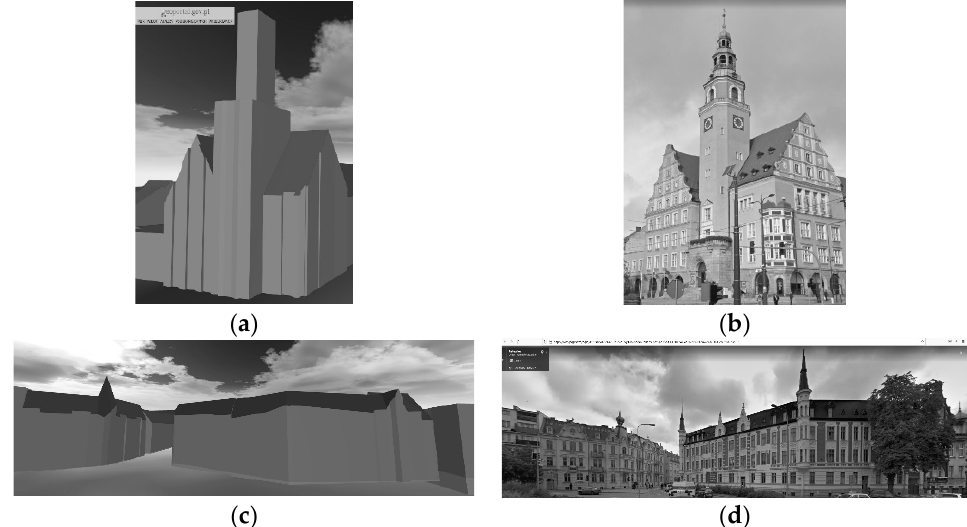
Figure 1. Selected 3D building models from the Polish SDI Geoportal, including Street View visualizations; ( a ) Model of the Olsztyn City Hall building; ( b ) Visualization of the Olsztyn City Hall building; ( c ) Models of other representative buildings and their visualizations ( d ).